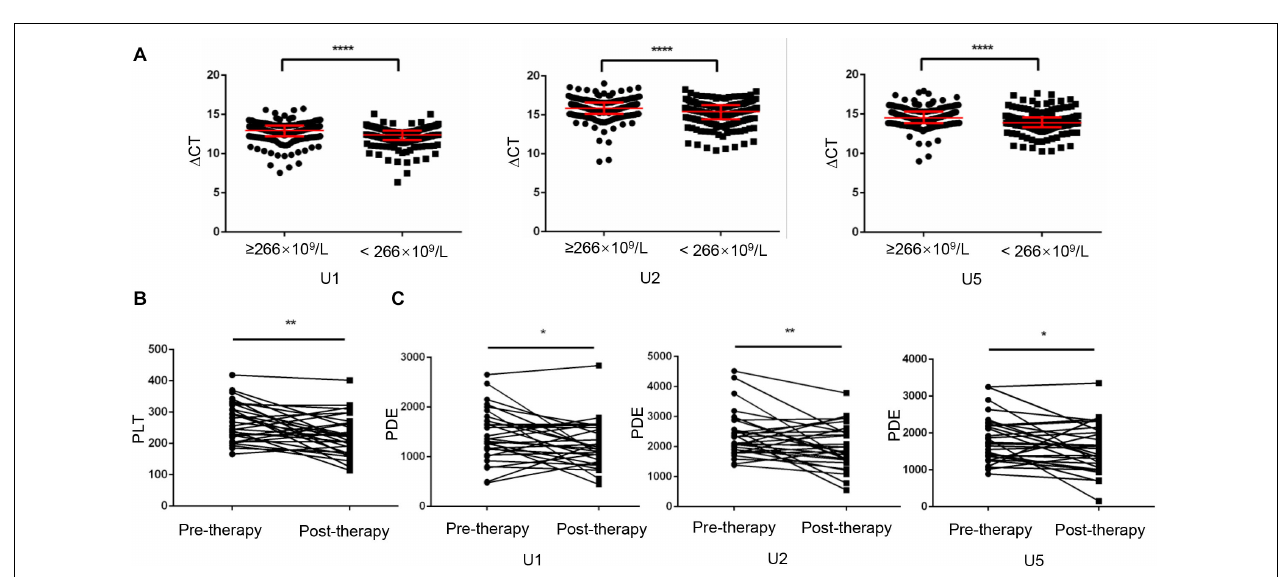
FIGURE 4 | TEP U1, U2, U5 as biomarkers for lung cancer progression monitoring. (A) The ROC curve analysis of U1, U2, U5 and their combination for lung cancer progression; (B) The ROC curve analysis of CEA for lung cancer progression combined with U1, U2, U5; **** P < 0.0001.